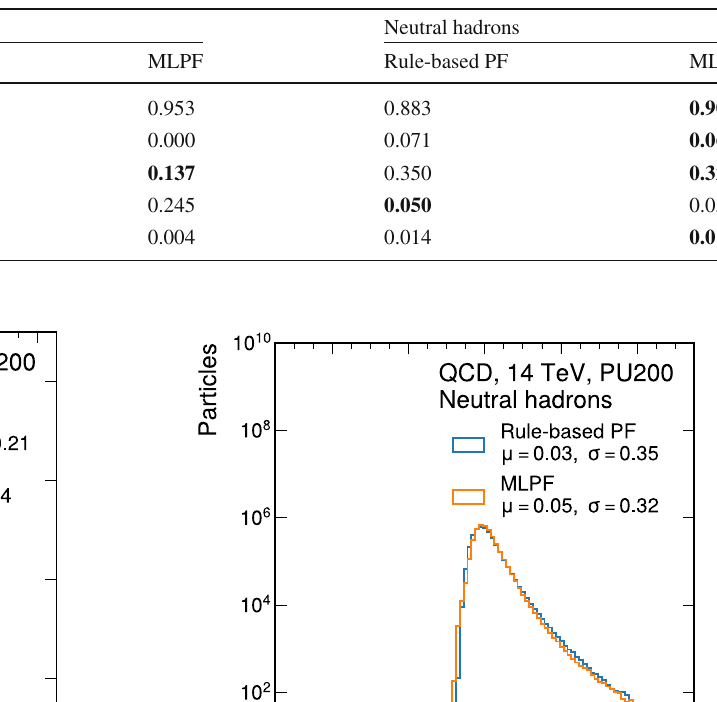
Table 1 Particle reconstruction efficiency and fake rate, multiplicity N , p T ( E ) and η resolutions for charged (neutral) hadrons, comparing the rule-based PF baseline and the proposed MLPF method. Bolded values indicate better performance